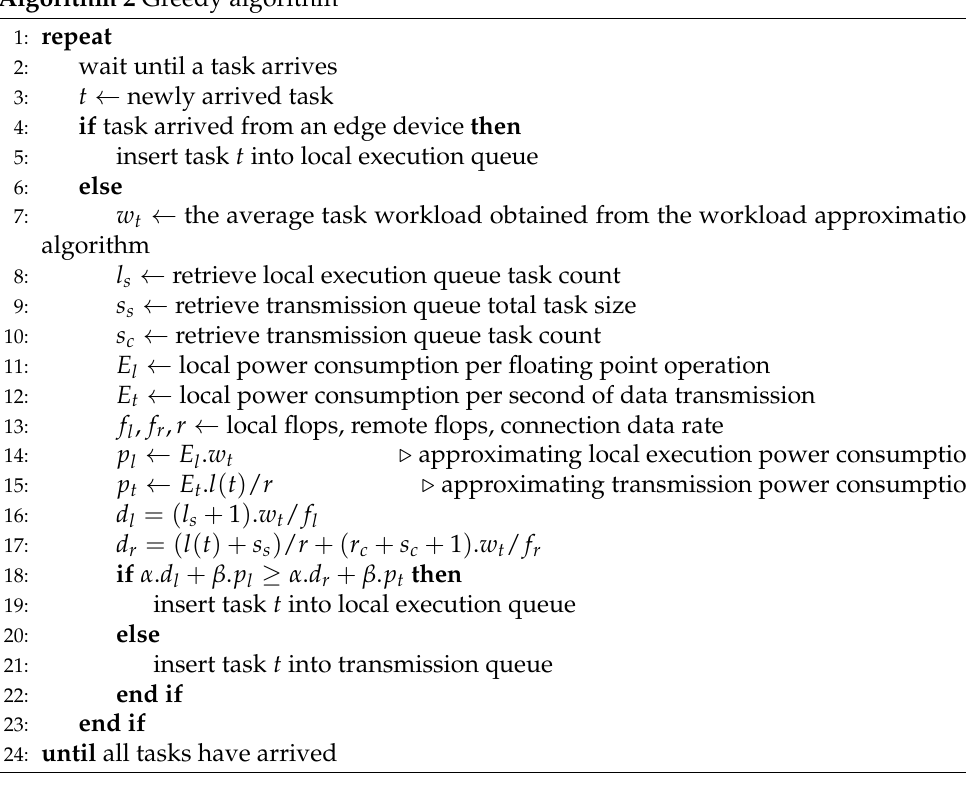
Algorithm 2 Greedy algorithm